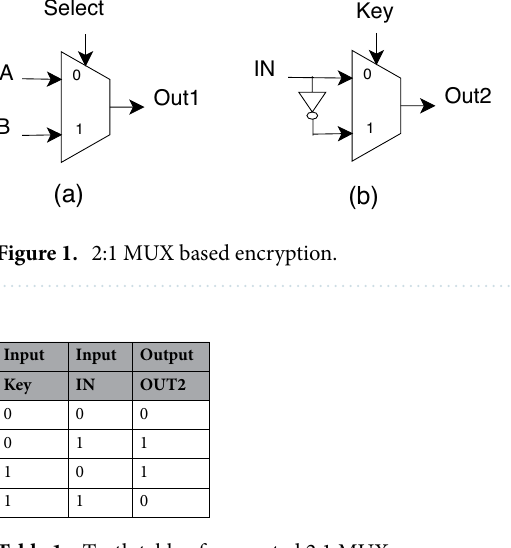
Table 1. Truth table of encrypted 2:1 MUX.